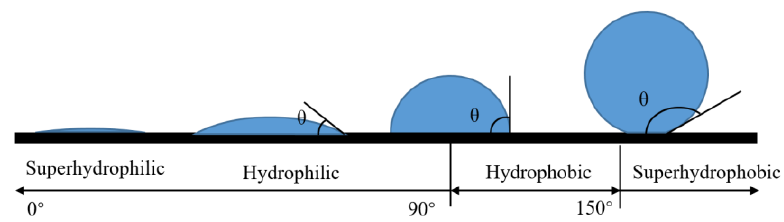
Figure 2. Division of wettability by contact angle.